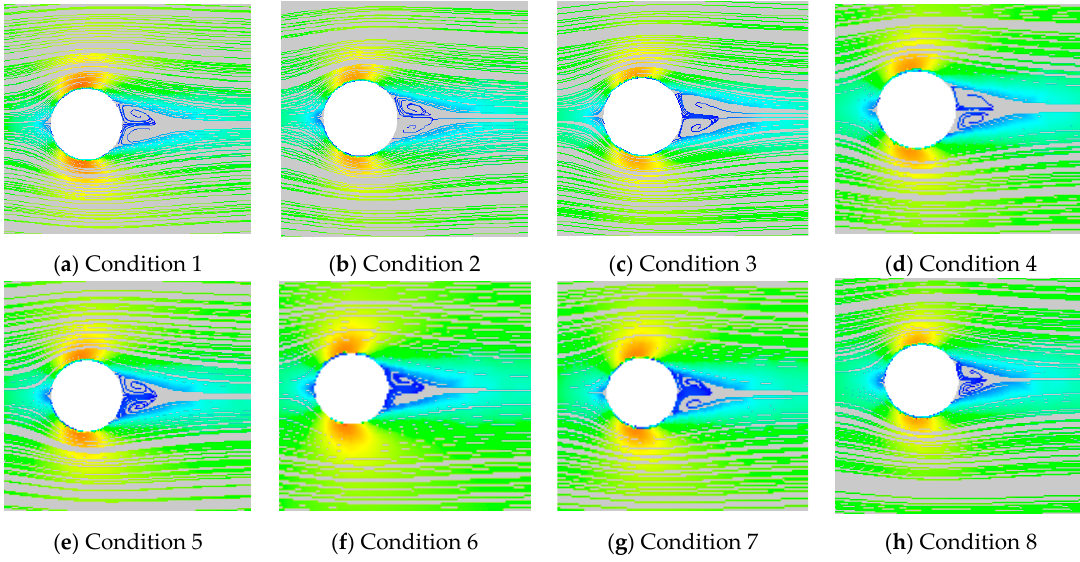
Figure 18. Wind speed streamlines of the undisturbed zone.